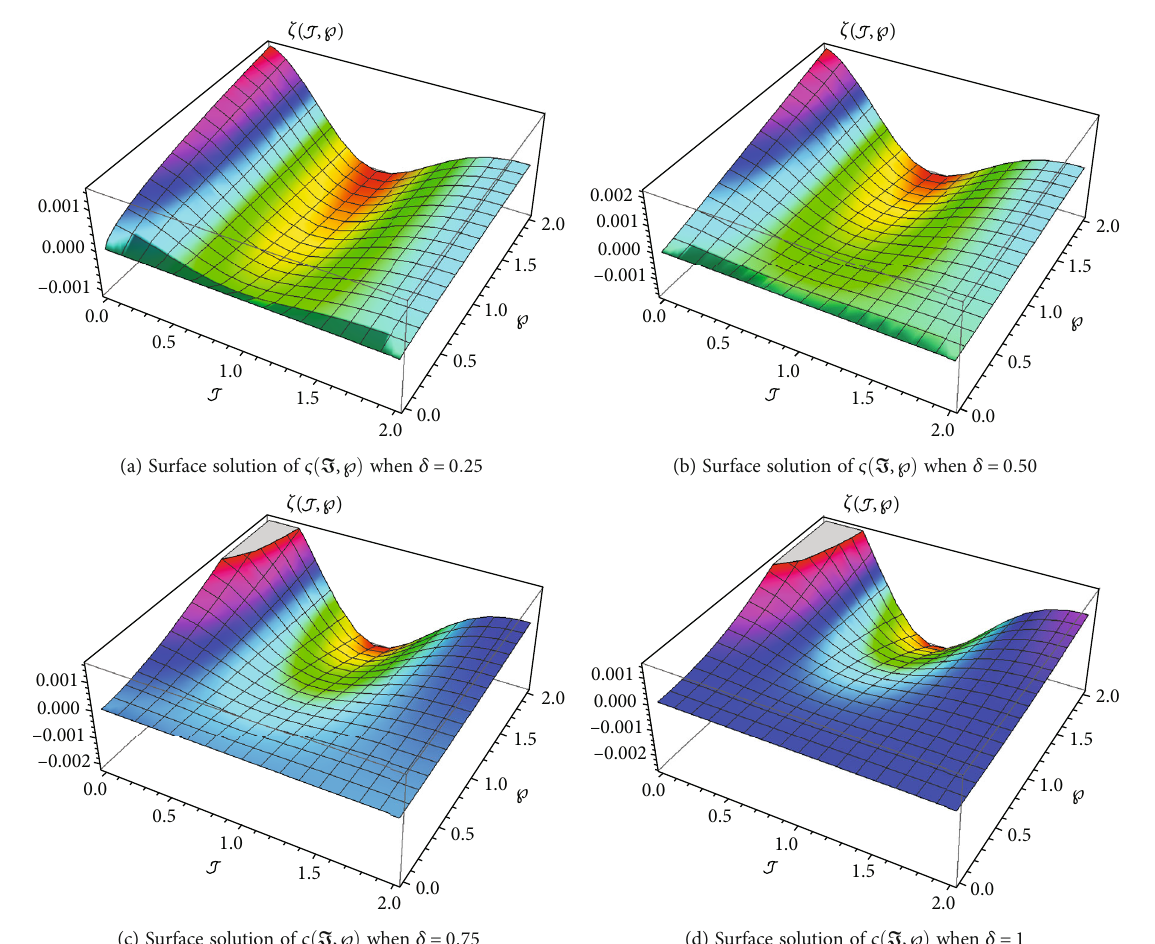
Figure 4: The surface solution of ς ð I , ℘ Þ for distinct values of δ